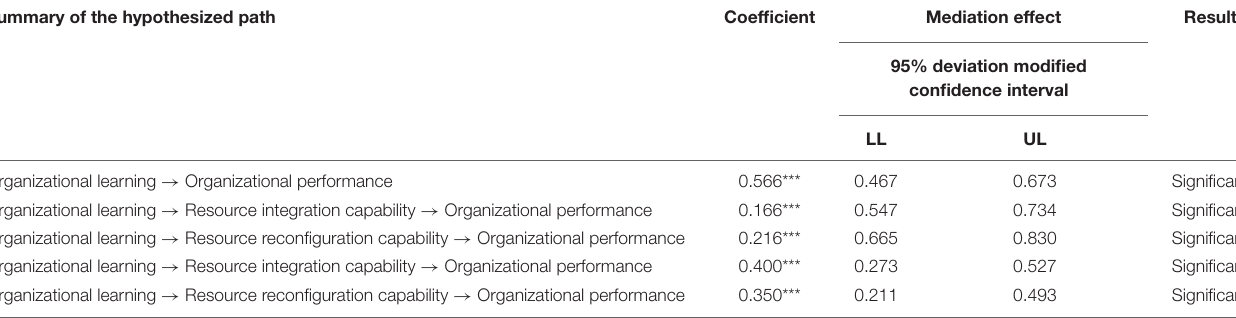
TABLE 10 | Bootstrap mediation effects testing. Summary of the hypothesized